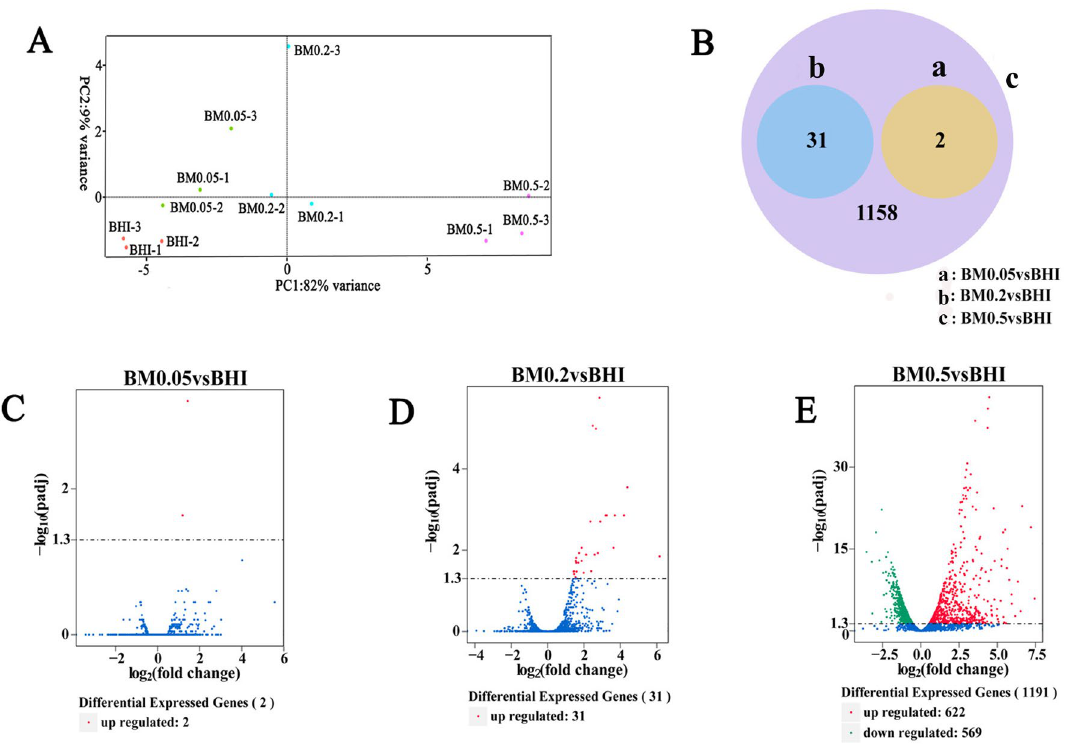
Figure 2. DEGs in A. muciniphila in response to mucin. ( A ) scatter plot of principal component analysis; ( B ) Venn diagram of DEGs; ( C ) Volcano plot of DEGs in BM0.05; ( D ) Volcano plot of DEGs in BM0.2; ( E ) Volcano plot of DEGs in BM0.5. Red spots represent upregulated genes, and green spots represent downregulated genes.